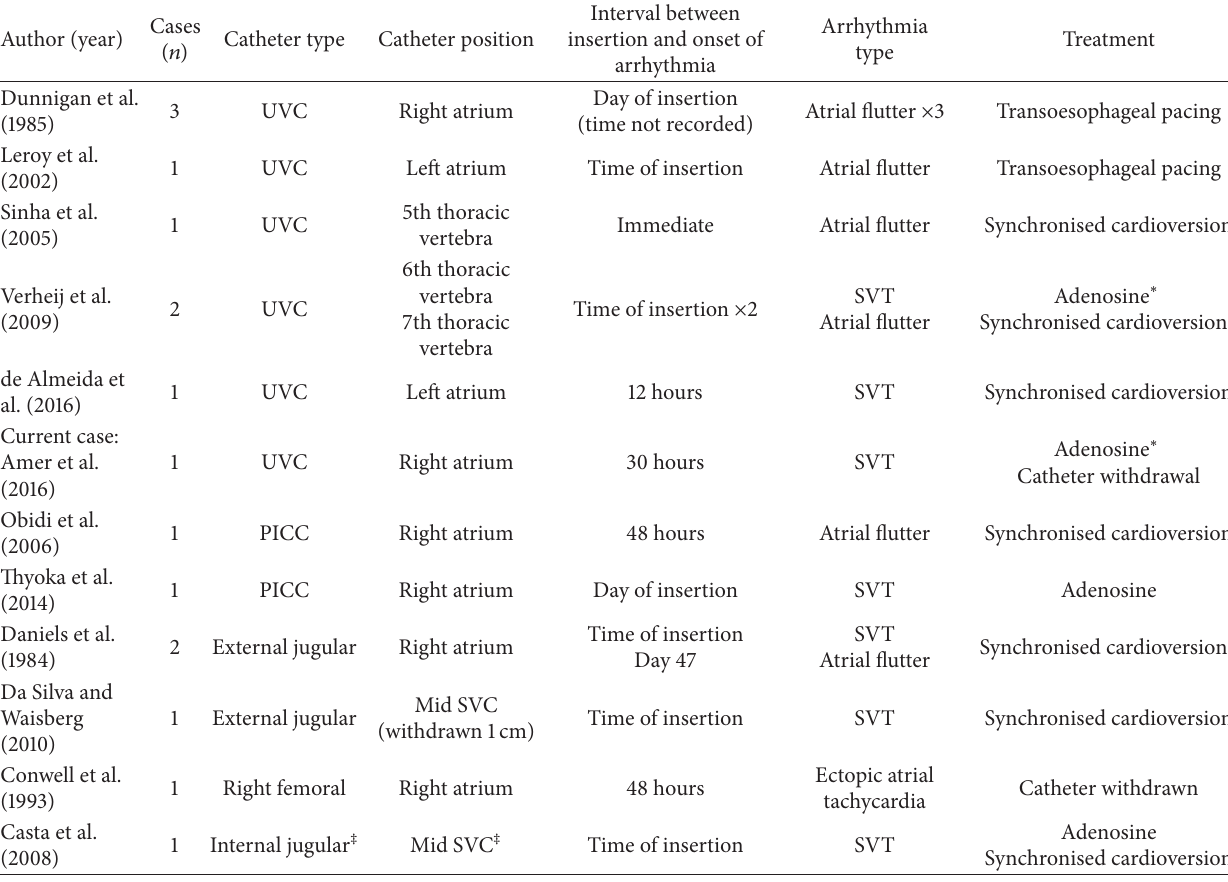
Table 1: Reported cases of rapid atrial arrhythmias associated with central venous catheters in neonates.